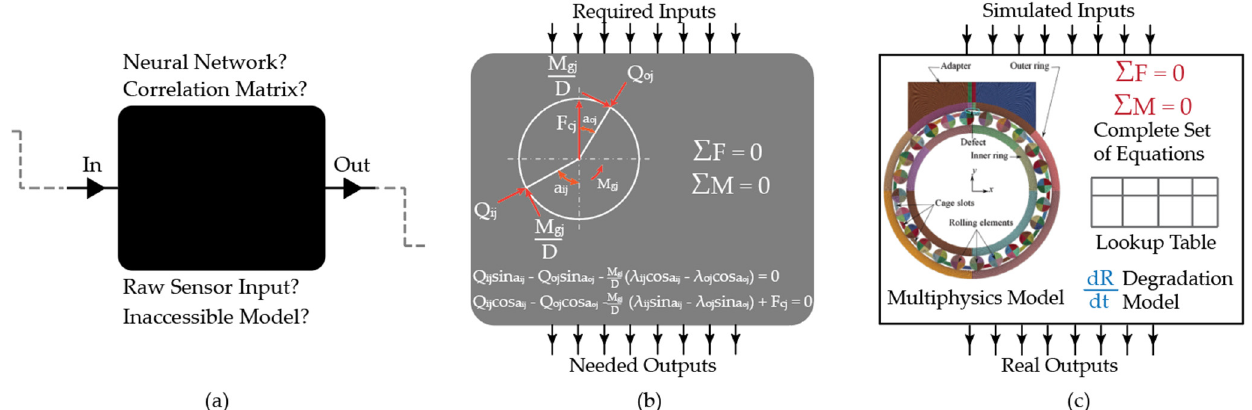
Figure 4. Example of a model bearing component in the three different “box” iterations. ( a ) Black Box; ( b ) Grey Box; ( c ) White Box. Black boxes are unknown to the model and can draw their solution from several sources. Grey boxes are models describing the mechanics and nature of the component, using theoretical data to complete it. White boxes are fully known to the user, customized for the application and simulate the component with near perfect accuracy. Analysis derived from [45], FEM model in ( c ) courtesy of [46].